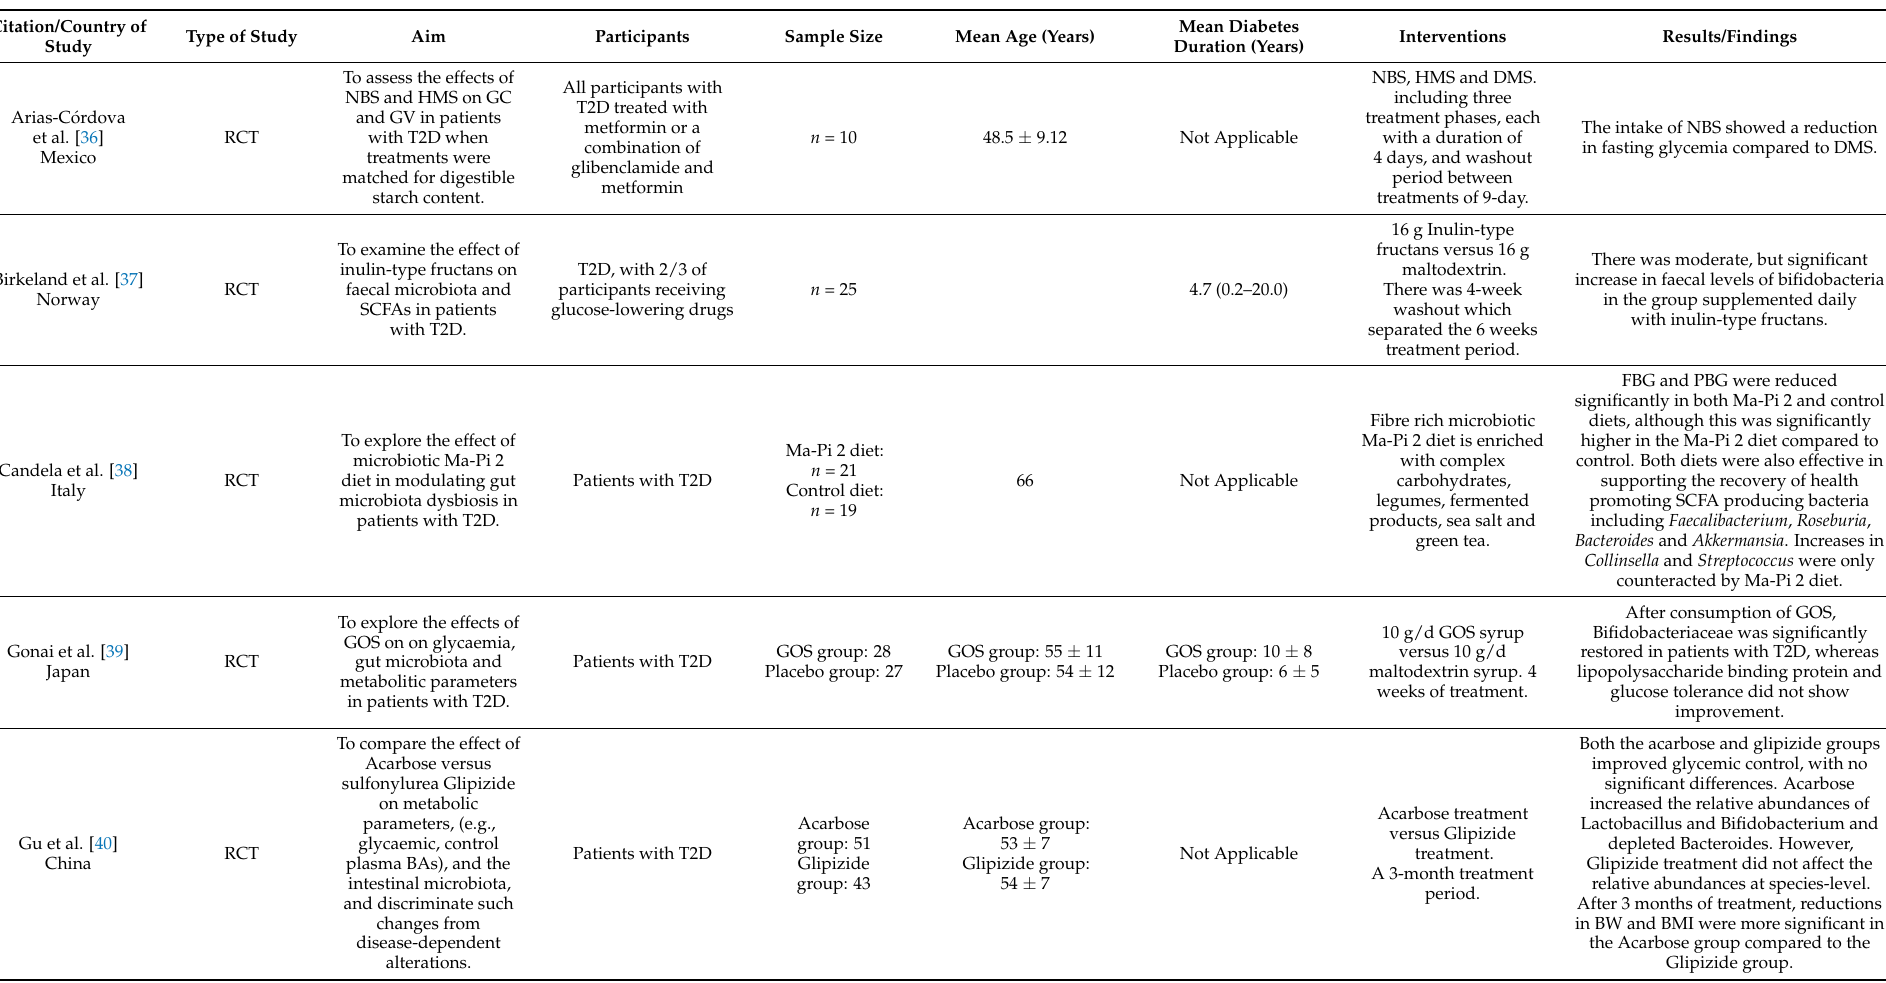
Table 2. Description and characteristics of studies